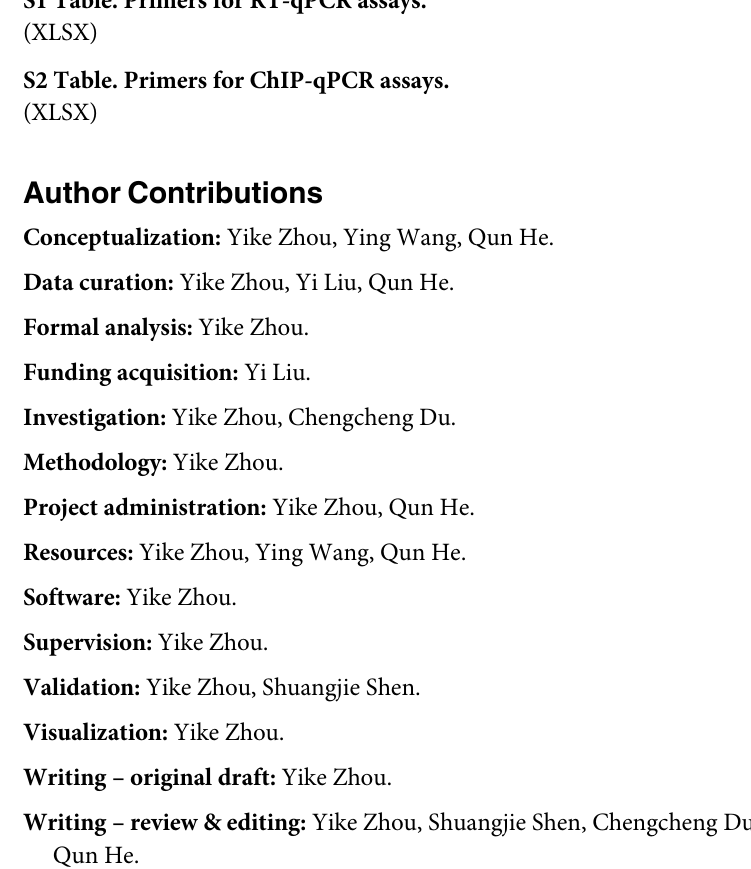
S1 Table. Primers for RT-qPCR assays. S2 Table. Primers for ChIP-qPCR